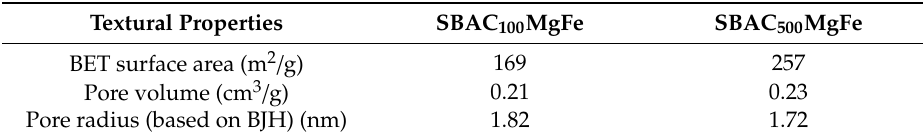
Figure 3. N 2 adsorption–desorption isotherm curves for SBAC 100 MgFe and SBAC 500 MgFe composites ( a ); pore size distributions of SBAC 100 MgFe and SBAC 500 MgFe composites ( b ); vibrating sample magnetometry plot of SBAC 100 MgFe composite ( c ); removal of magnetic composites from solution using a magnet ( d ). Table 2. Textural properties of SBAC-MgFe